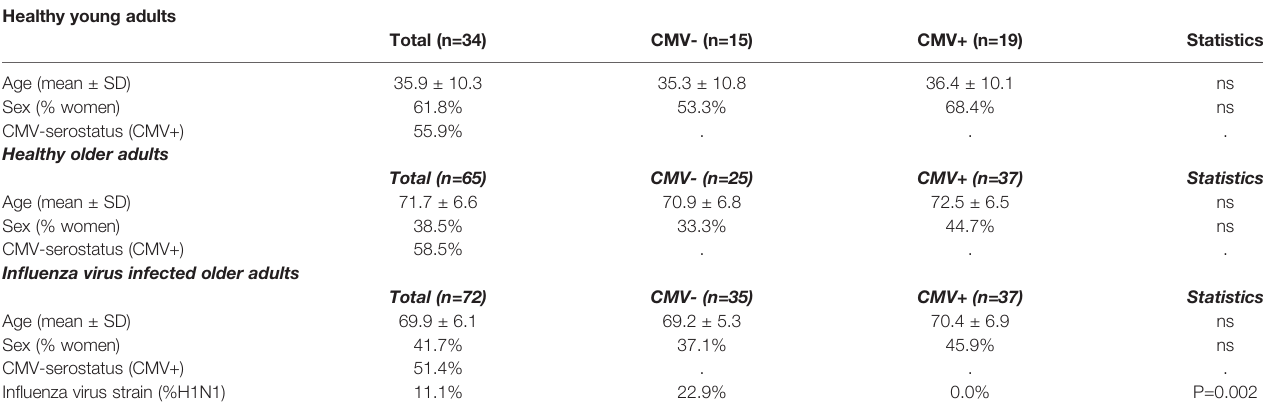
TABLE 1 | Characteristics of the study